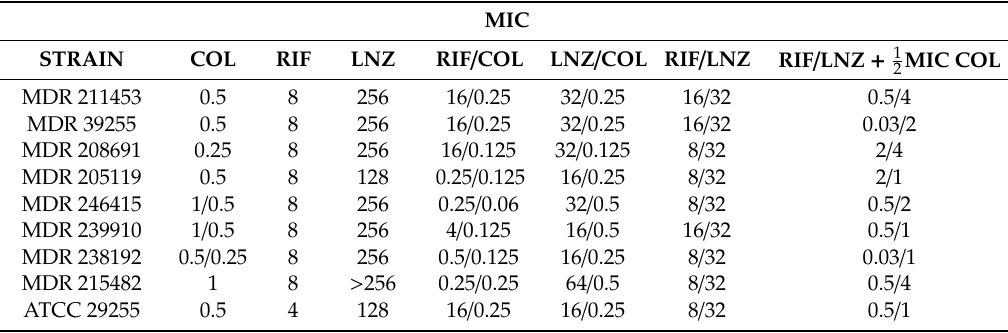
Table 1. Minimum inhibitory concentrations (MICs) according to EUCAST [16] and values for the combination of rifampin–linezolid with subinhibitory concentrations of colistin.